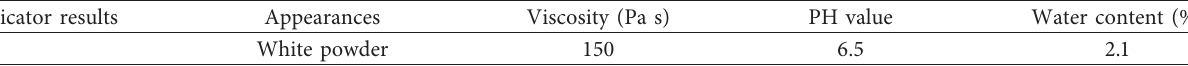
Figure 3: Foam preparation process. Table 4: Physical performance indicators of HPMC.